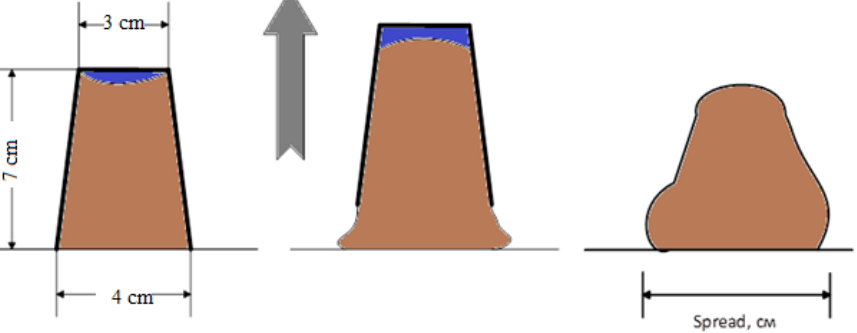
Figure 12. Schematic process for determining the plasticizing ability of additives for cement systems.